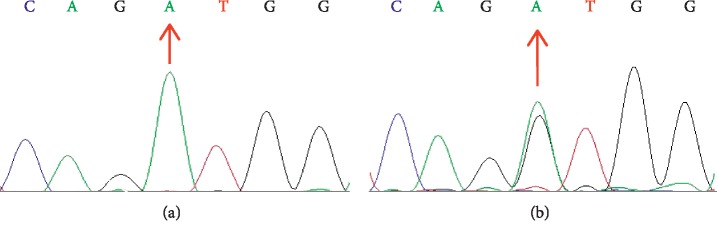
Sanger sequencing chromatogram showing a portion of the sequenced region of OPA1. (a) A wildtype (arrow) of a control. (b) A heterozygous missense mutation (c.1313A>G, arrow) of a patient.